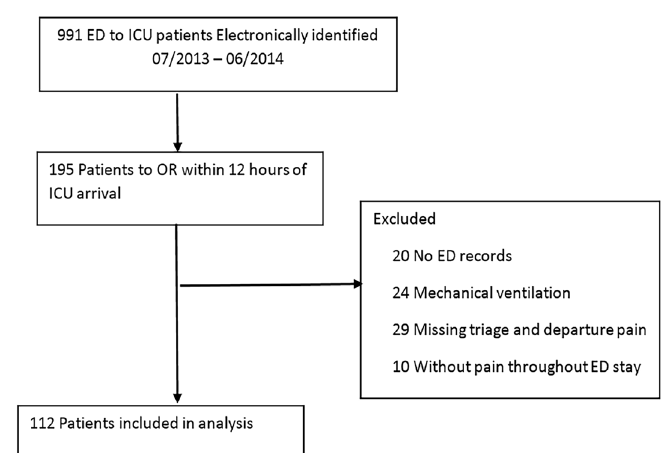
Figure 1. Patient selection